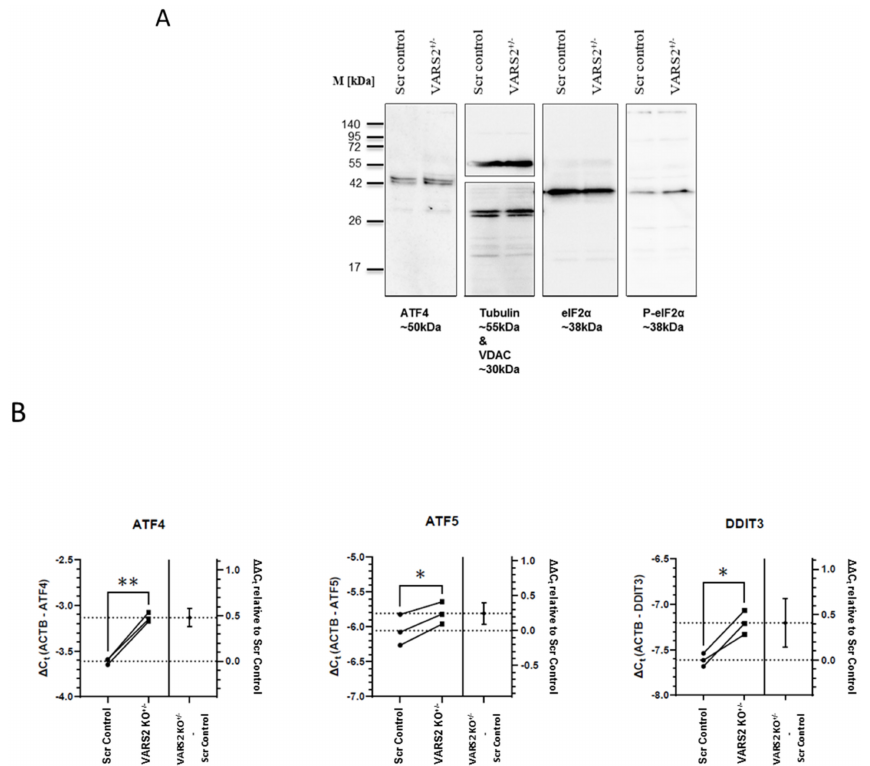
Figure 4. Western blot analyses showing a trend of a higher degree of eIF-2 α phosphorylation in VARS2 KO +/ − cells (2.25x) compared to the controls ( A ). RT-qPCR results indicating a higher level of ATF4, ATF5 and DDIT3 (CHOP) transcripts in the VARS2 +/ − compared to the control cell line ( B ). * = p < 0.05 and ** = p < 0.01.